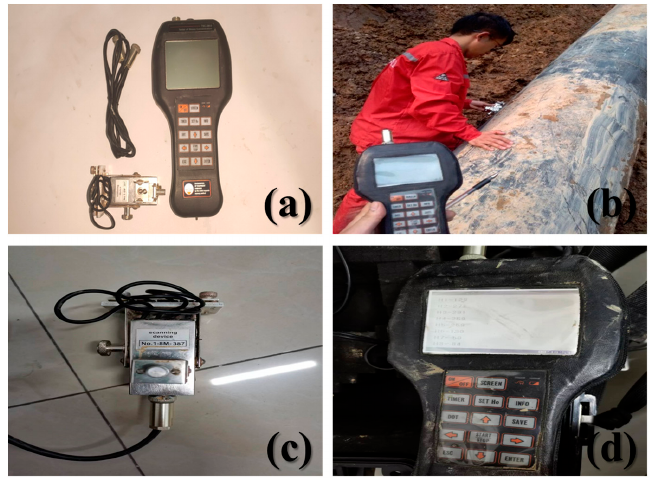
Figure 2. Non-contact 3D magnetic testing system. ( a ) The whole testing instrument; ( b ) Field operation; ( c ) data collector; ( d ) data analyzer Table 2. Technical parameters of tsc (Triaxial Stress Concentration)-2 m-8 tester.